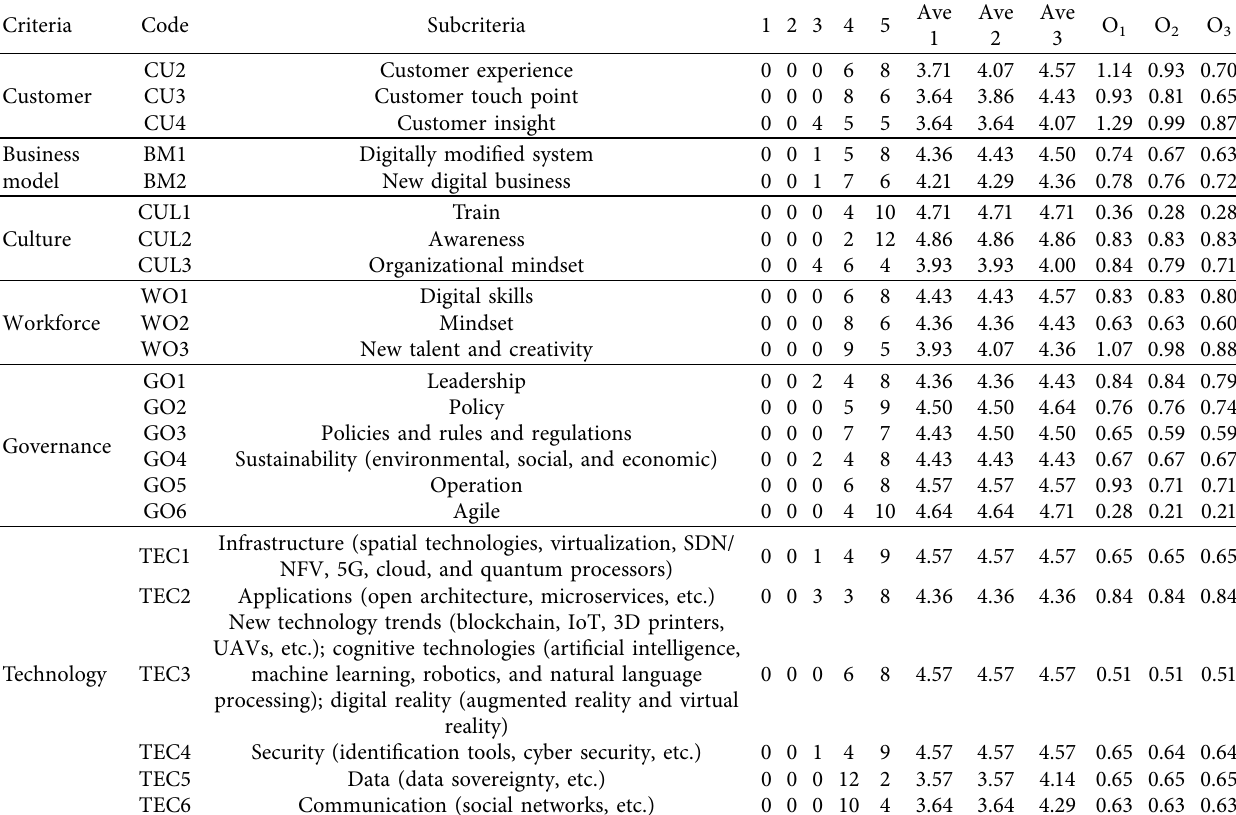
Table 2: Summarizing expert